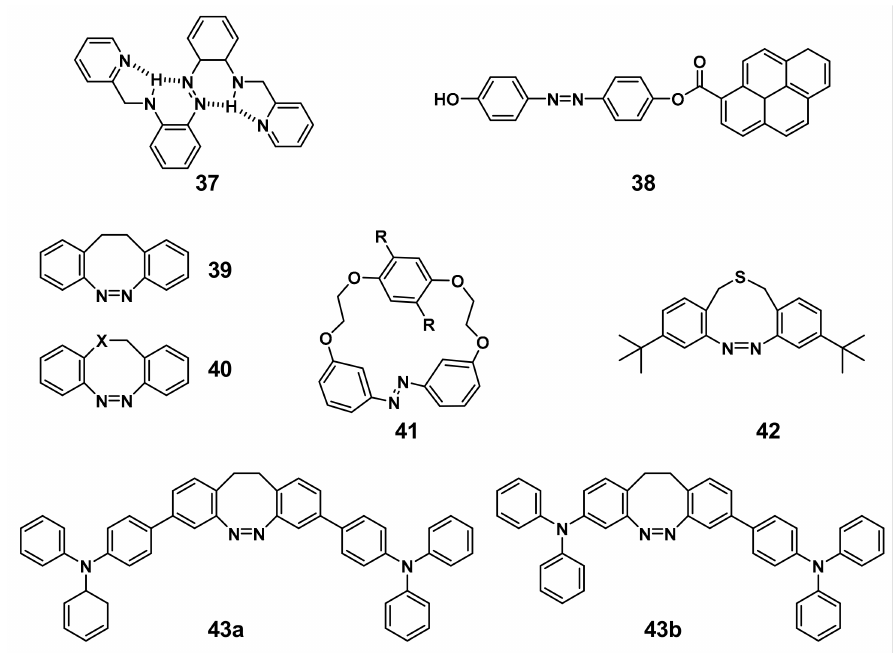
Figure 19. The molecular structure of azobenzene compounds 37 – 43 .